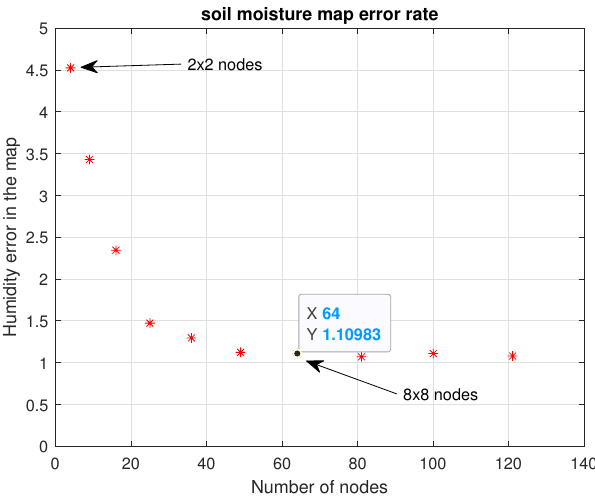
Figure 18. Error encountered for n × n nodes. Third experimental